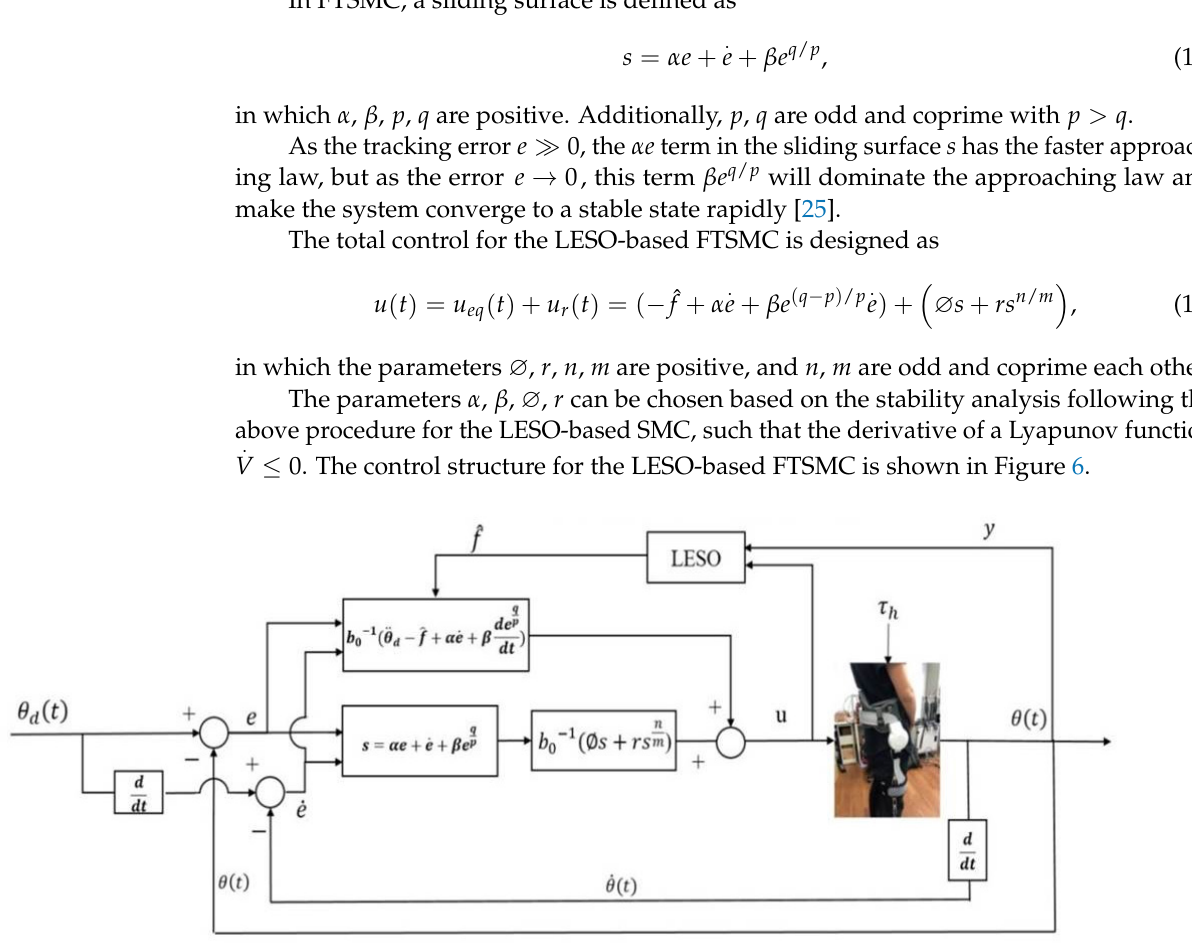
Figure 6. Control structure of LESO-based FTSMC.